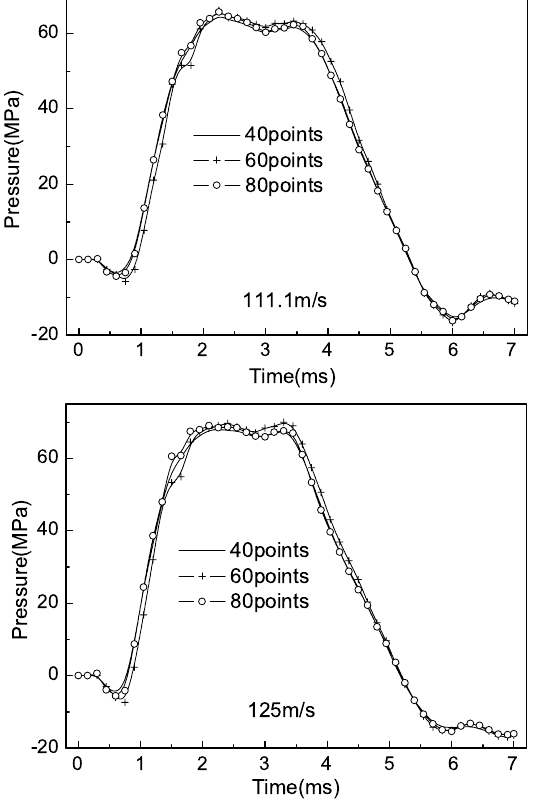
Fig. 13. Time history of pressure at the center on outer surface for different mesh seeds along camber line of